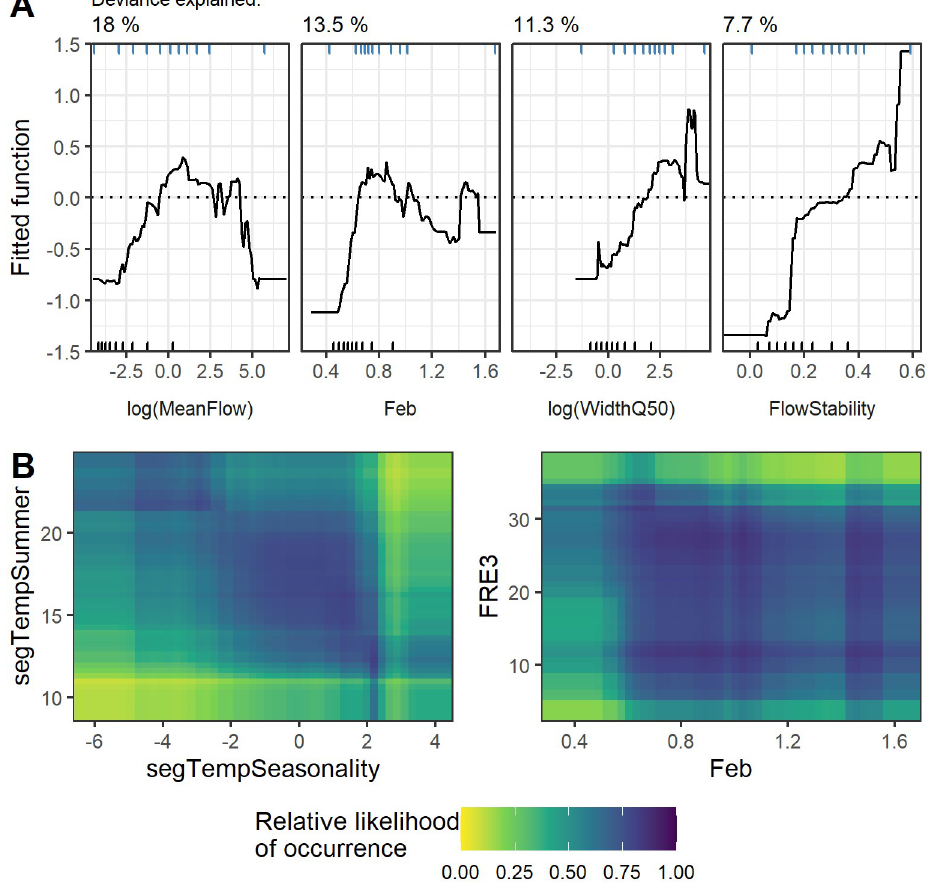
Fig 3. Key relationships between habitat and the relative likelihood of occurrence (RLO) for whio. (A) The four most important predictors in the full boosted regression tree (BRT) model. The dotted line represents the threshold above which whio occurrence is likely. Decile ticks at the bottom of each plot show how the contemporary New Zealand riverine environment is distributed for each predictor, while decile ticks at the top of each plot show how whio are distributed. (B) Partial dependence plots for the two strongest interactions in the full BRT model of whio occurrence, with darker colors indicating environmental space where whio are mostly likely to occur. To produce the plots, predictors except those plotted were held at their means. See Table 1 for predictor descriptions and